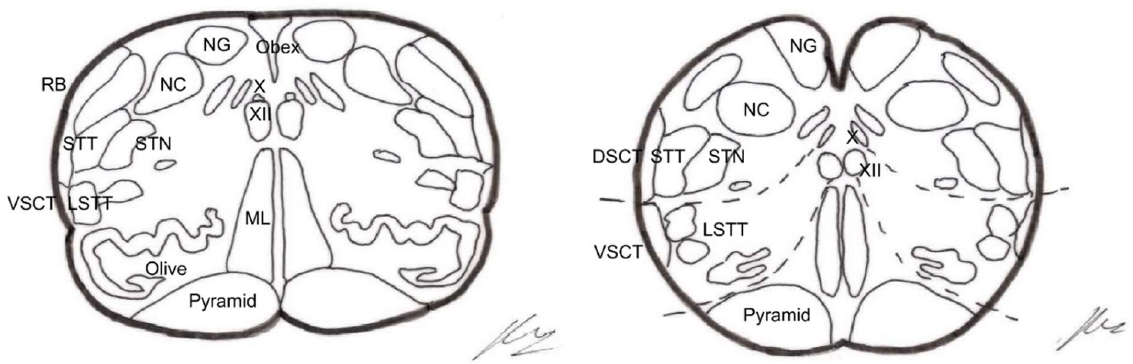
Figure 11. Trigeminal nucleotomy (see text). Section approximately 18 mm below the obex (modified from [122]). GF—Gracile Fasciculus. CF—Cuneate Fasciculus. STrigT—Spinal Trigeminal Tract. STrigN—Spinal Trigeminal Nucleus. AECT—Anterior Spinocerebellar Tract. PECT—Posterior Spinocerebellar Tract. LCET—Lateral Corticospinal Tract. GP—Gelatinosa Portion of Spinal Trigeminal Nucleus. MC—Magnocelllular Portion of Spinal Trigeminal Nucleus. RST—Rubrospinal Tract. ALS—Anterolateral System.